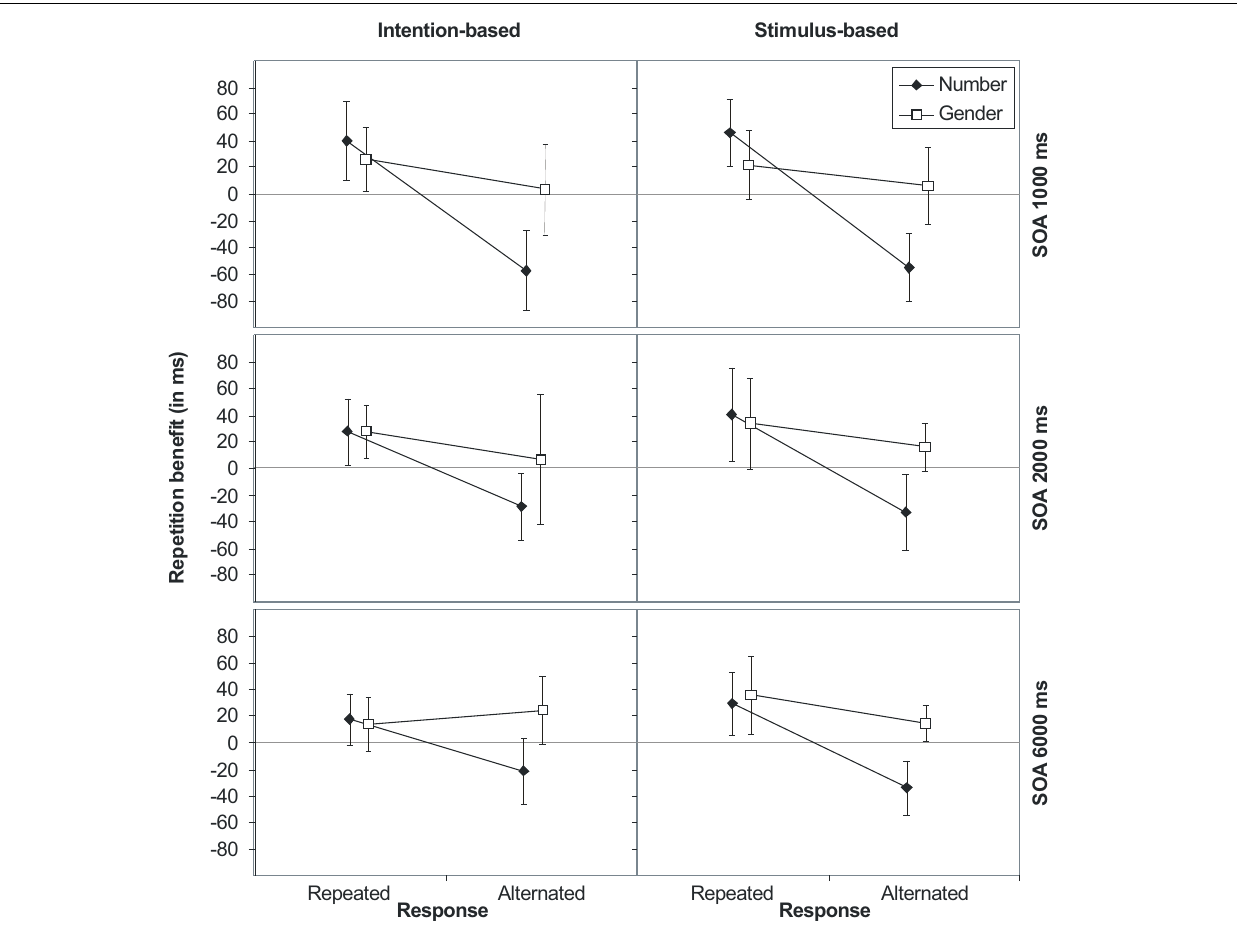
FIGURE 2 | Stimulus (S1–S2) repetition benefits (RT alternation -RT repetition ) in Experiment 1 for stimulus features number and gender for intention-based (left panels) and stimulus-based trials (right panels) as a function of response relation (R1–R2 repetition or alternation) and